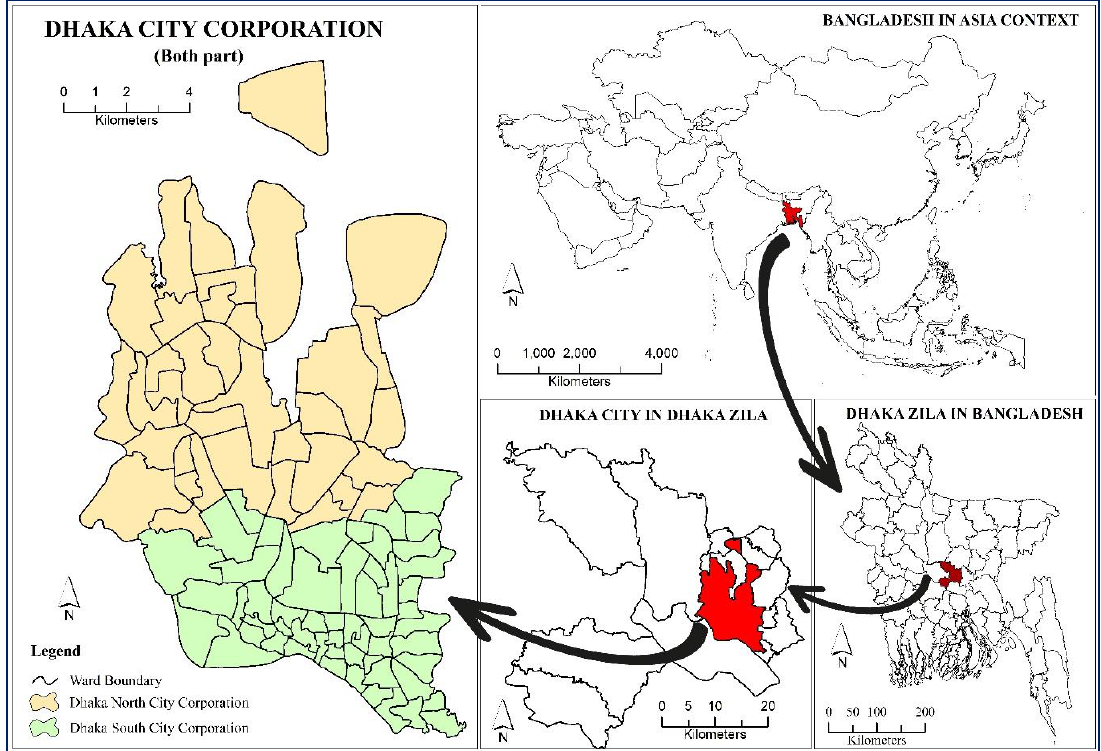
Figure 1. Location map of the study area in the context of various administrative units of Bangladesh and Asia.